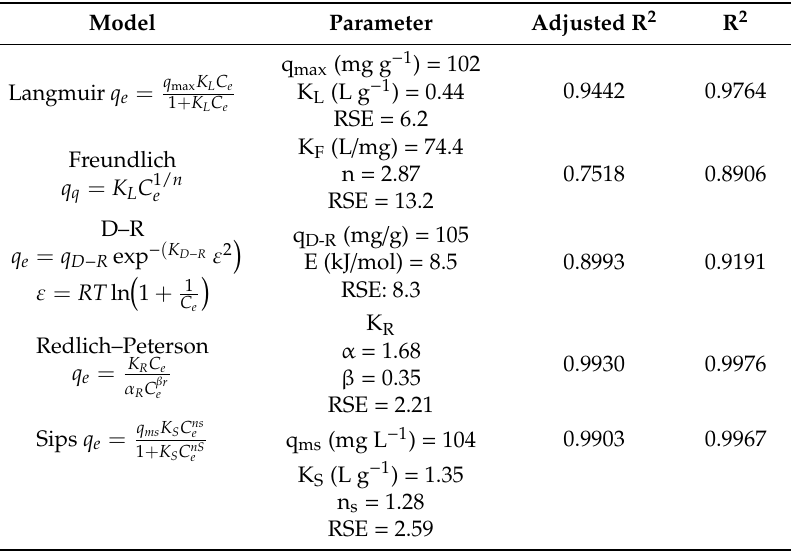
Table 2. Non-linear adjusted adsorption isotherms.